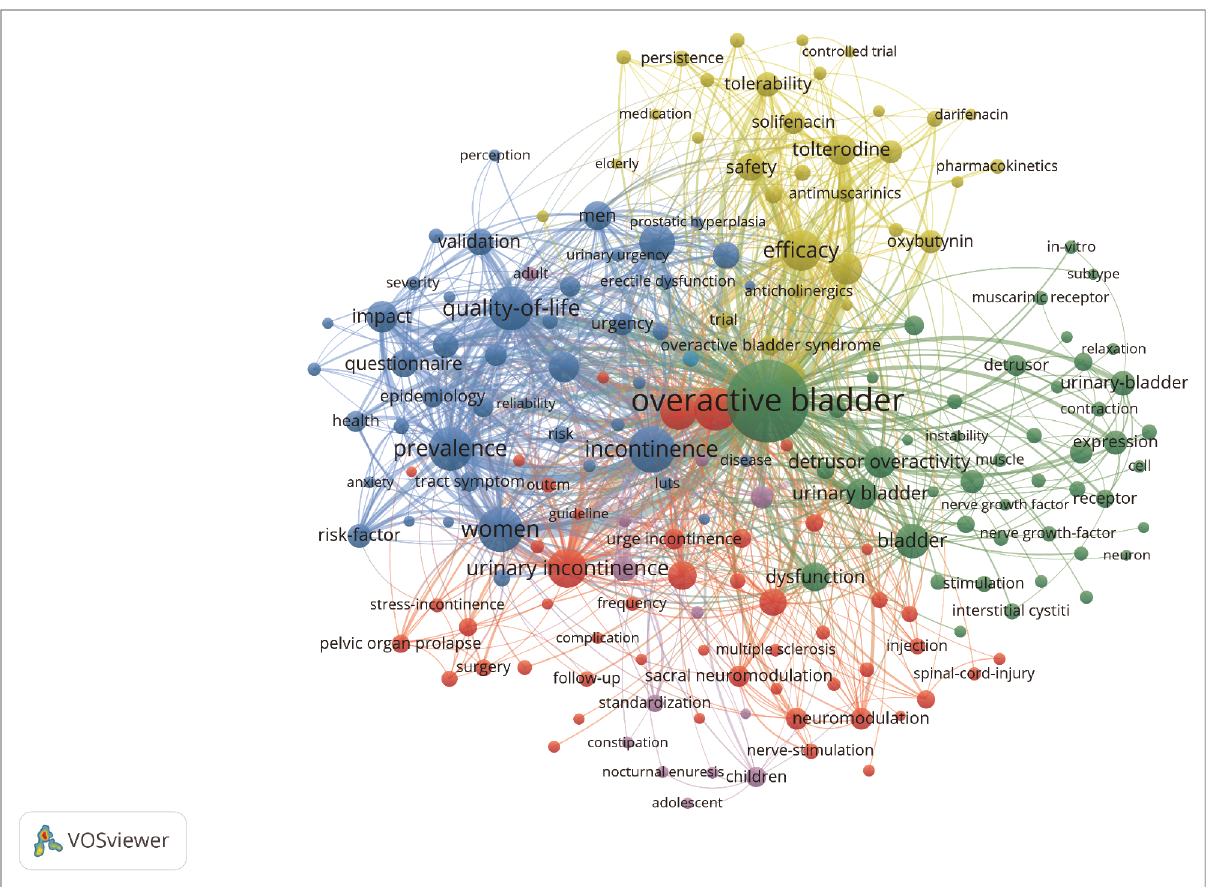
FIGURE 6 Mapping of the keywords in the fi eld of overactive bladder. Different colors represent different